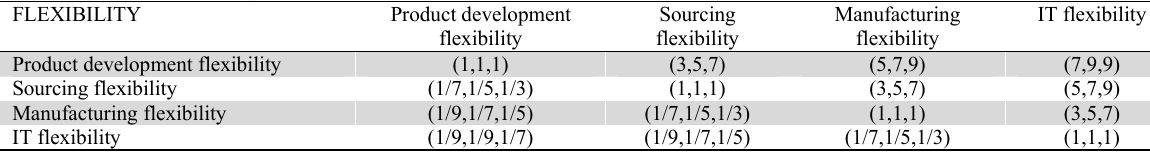
Fuzzy pair-wise comparison of Flexibility Enablers